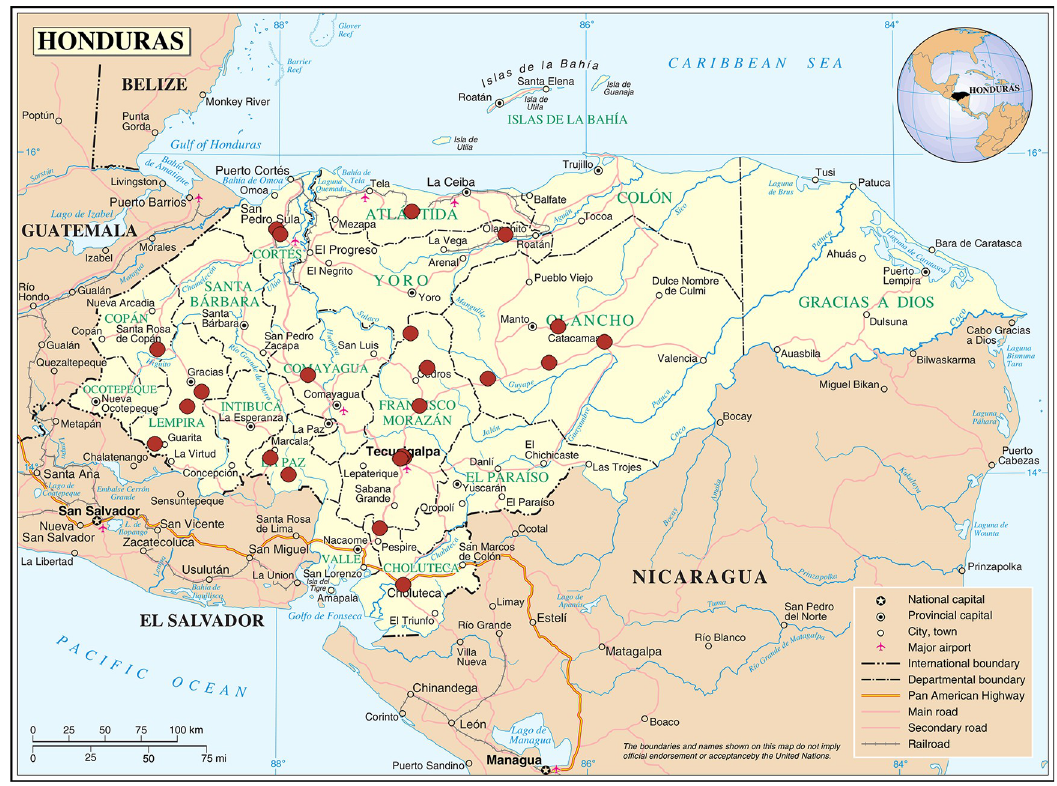
Fig 1. Location of the 22 daycare centers and nursing homes, study of knowledge, attitudes and practices of seasonal influenza vaccination, older adults, Honduras, 2018. Source: This map is a public domain file provided by the Central Intelligence Agency’s World Factbook,